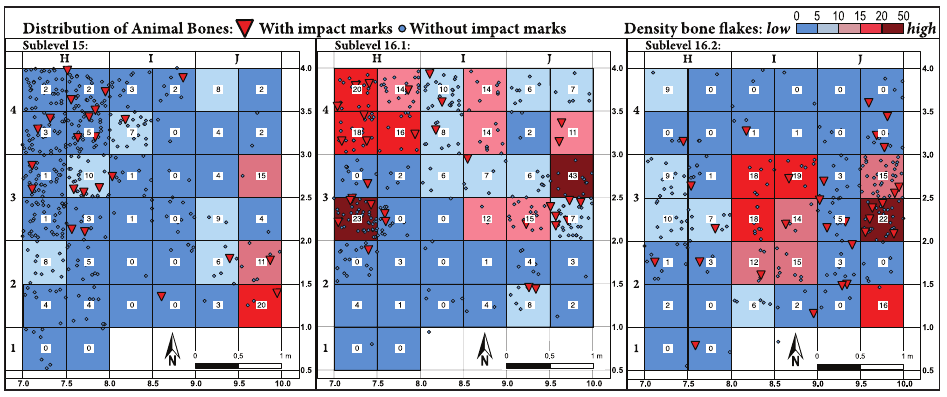
Figure 6: The two components, impact marks on bones and bone flakes or chips, are com- bined to achieve the distribution of bone working areas contributing to marrow extracting or grease rendering activities. Individual faunal remains with impact marks are plotted indi- vidually. Based on the counts of bone flakes the subsquares were colour coded according to low and high densities, from blue to red respectively.